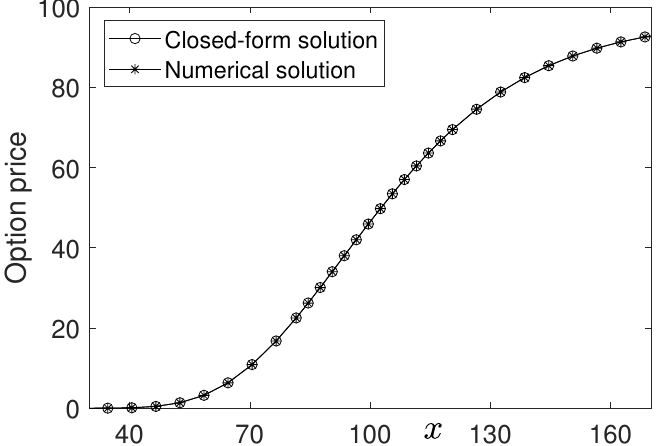
Figure 2. Comparison between the closed-form and the numerical solutions of cash-or-nothing option with Ω 3 .